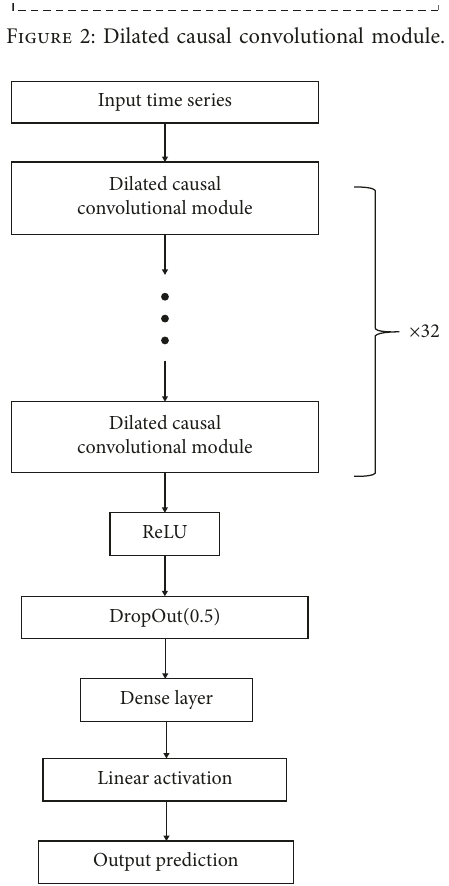
Figure 3: Deep dilated causal temporal